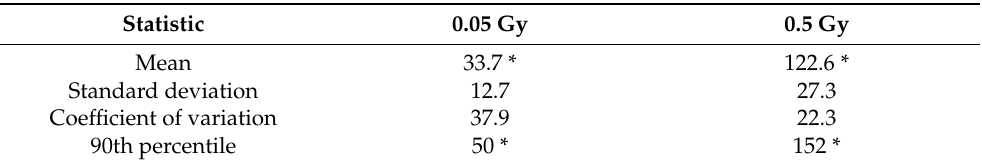
Table 1. Radiation-induced G2 chromsomal radiosensitivity scores of the healthy control donor cohort ( n = 45) at 0.05 Gy and 0.5 Gy IR